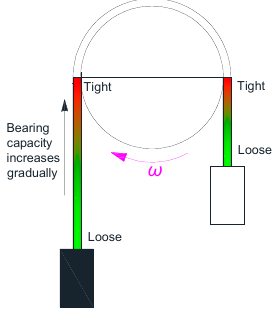
Figure 18. A sketch of load variation along rope length.